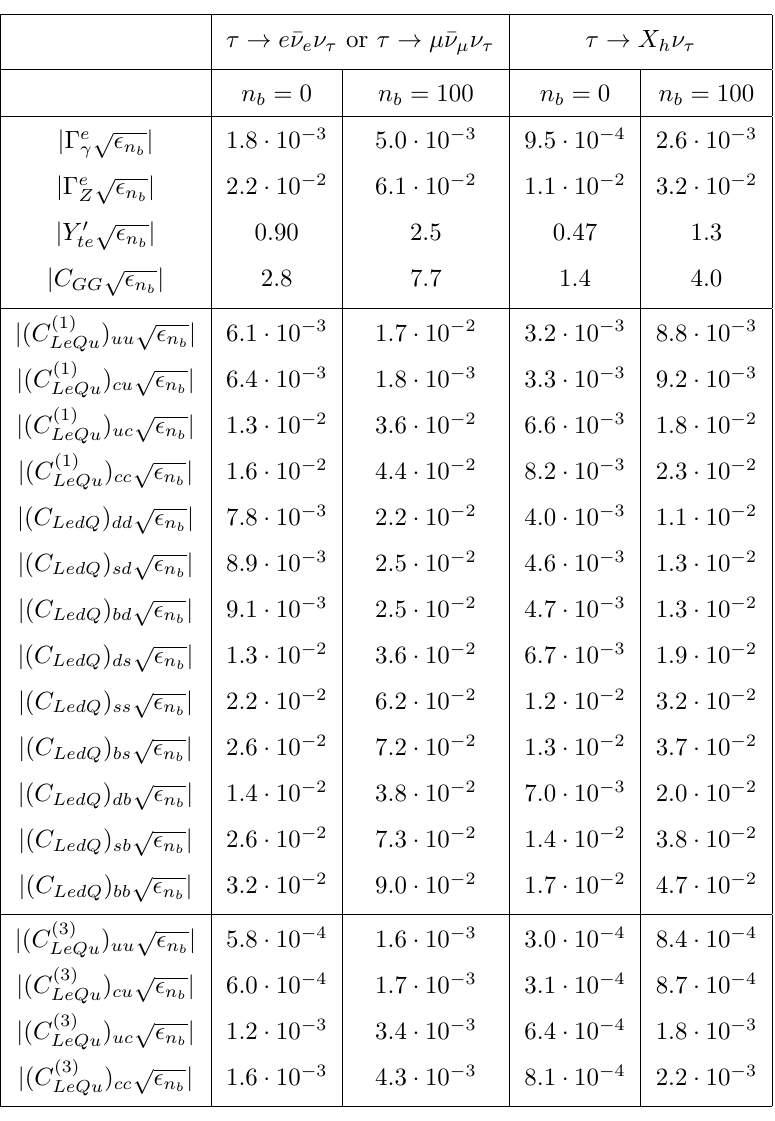
Table 5 . EIC sensitivity to CLFV γ and Z dipole couplings, Higgs couplings, gluon couplings and scalar and tensor four-fermion operators, from the τ electronic, muonic and hadronic decay √ channels. We assume S = 141 GeV and L = 100 fb − 1 . The two sets of 90% CL bounds are obtained assuming that the EIC will observe n = n = 0 and n = n = 100 events. (cid:15) and (cid:15) b b 0 100 accounts for the selection cuts that ensure 0 and 100 background events, respectively, and are functions of the decay channel and of the operator